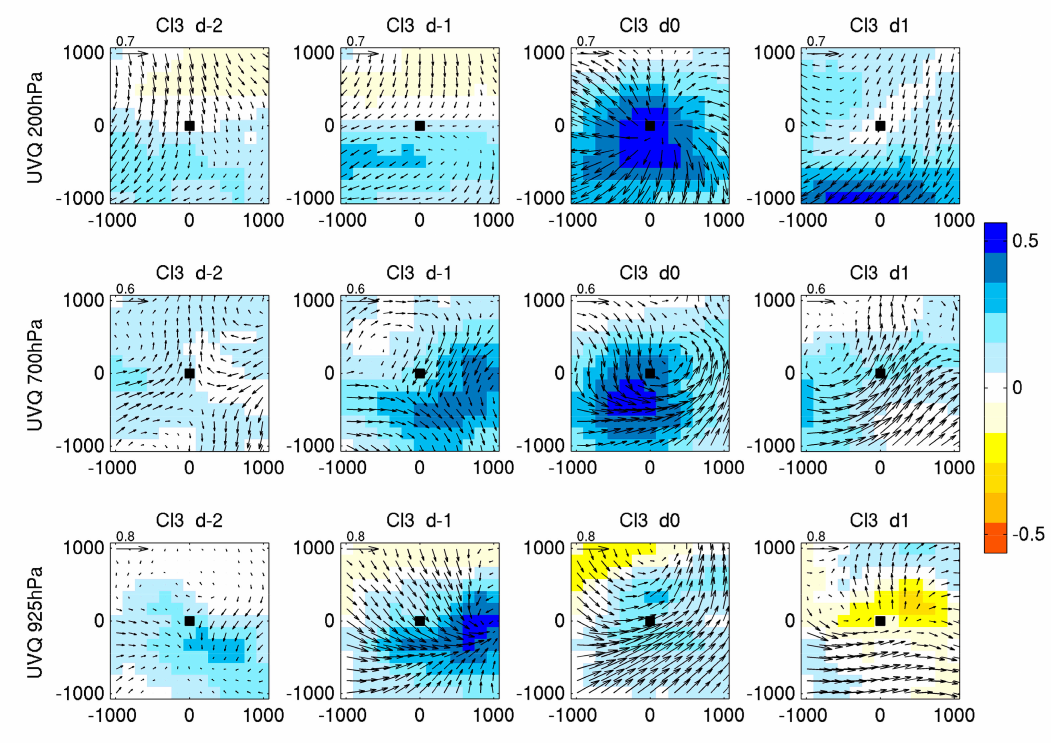
Figure 13. Same as Figure 11 but for cluster